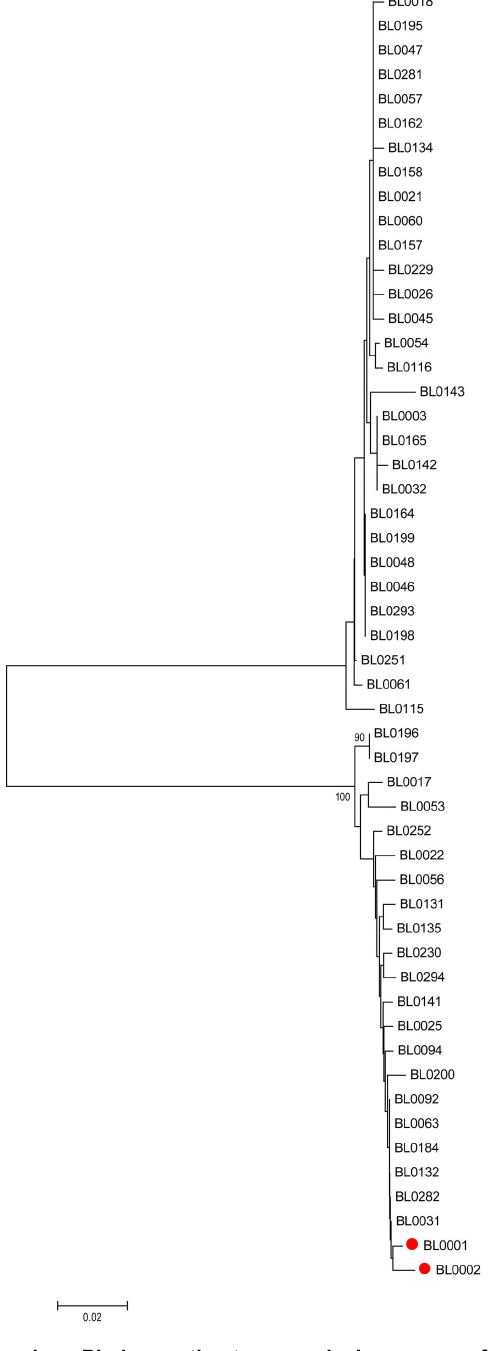
Figure 4. Phylogenetic tree analysis among family members. The Neighbor-joining phylogenetic tree was constructed based on the HCV Core gene from 53 cases in 23 families. The only cases from the same family that are clustered together (BL0001 and BL0002) were highlighted in red filled circle. Bootstrap values are based on 1 000 replicates and statistic values > 70% are indicated at the nodes of the corresponding branches. The scale bar unit is substitutions/ site. doi: 10.1371/journal.pone.0082304.g004 PLOS ONE |